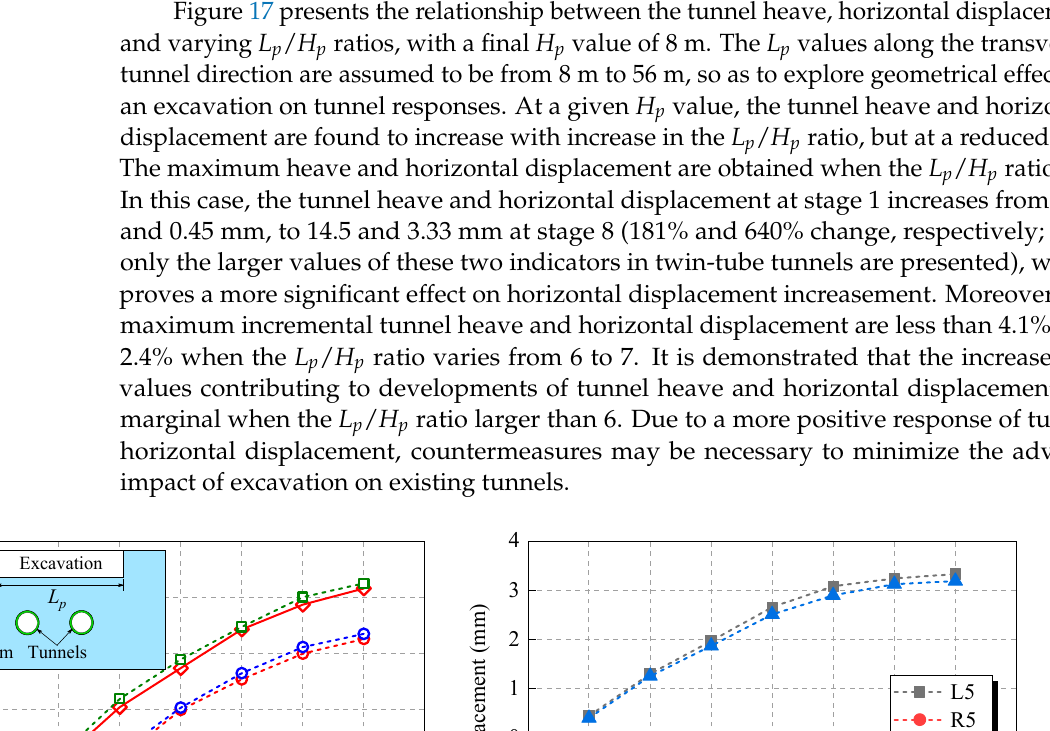
Figure 16. Influence of H / H p ratio on tunnel displacement.